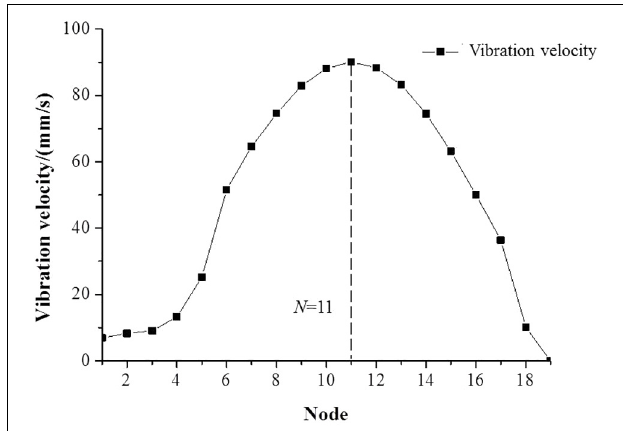
FIGURE 12 | The maximum vibration velocity of different monitoring